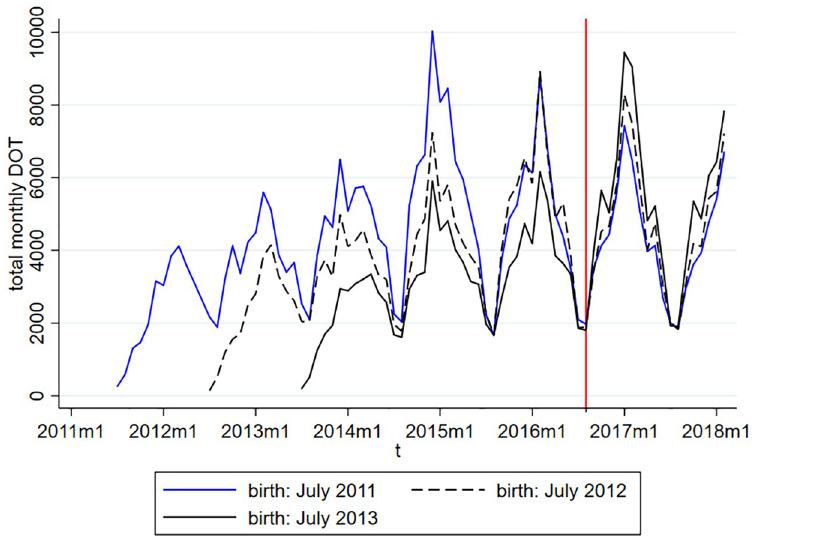
Fig 5. Country level time patterns of total antibiotic DOT for selected monthly cohorts.